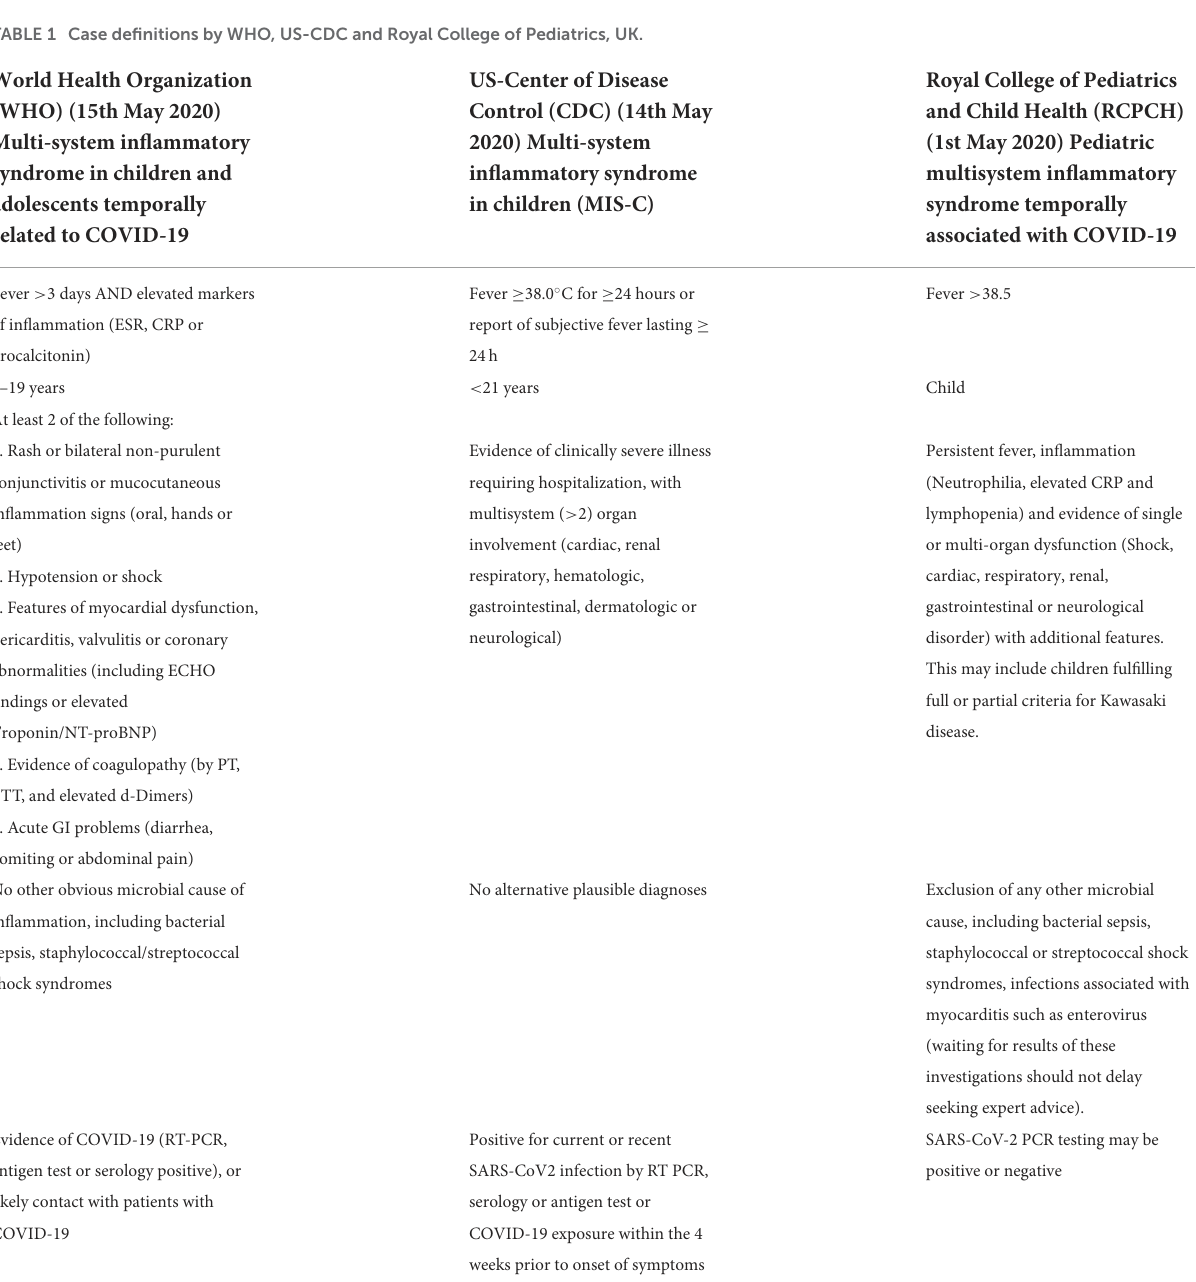
TABLE 1 Case definitions by WHO, US-CDC and Royal College of Pediatrics,